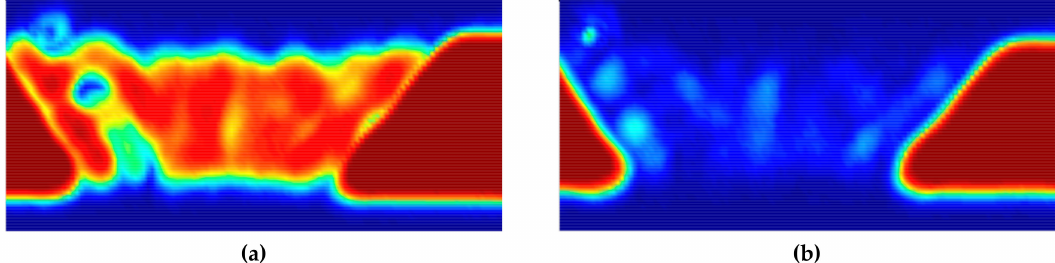
Figure 12. Ultrasonic images acquired by scanning the front plane of the dissimilar-metal-welded (DMW) specimen using ( a ) the first back-surface echo and ( b ) second back-surface echo through the ultrasonic pulse-echo method.